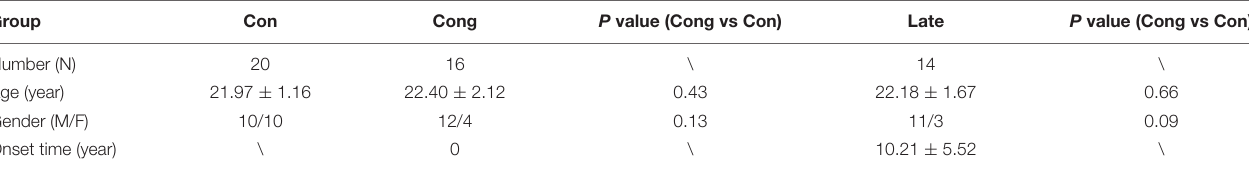
TABLE 1 | The demographic information of the cohort.